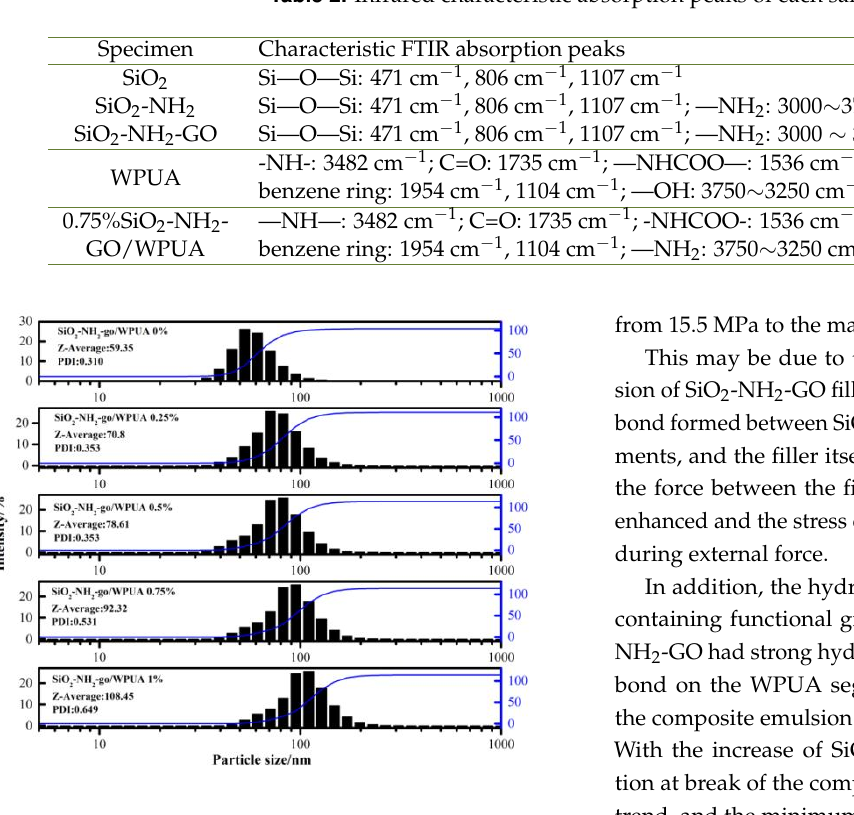
Fig. 2. Particle size distribution index of SiO 2 -NH 2 -GO/WPUA emulsion with different SiO 2 -NH 2 -GO contents